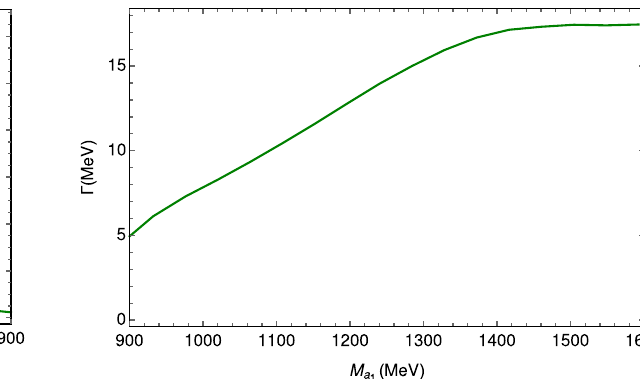
→ π + σ) from Eq. (28) as a function of M Fig. 4 (cid:8)( a + 1